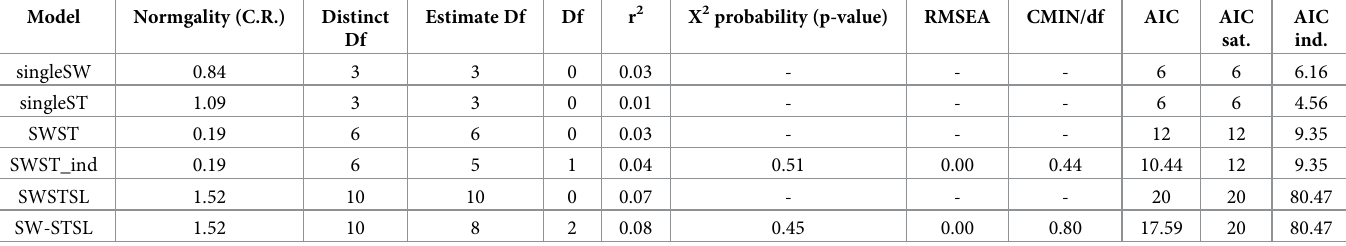
Table 1. Comparison of SEM models, with tests for multivariate normgality, distinct and estimated degrees of freedom, total variance explained, Chi-square statis- tic, Root-mean square error, Chi-square goodness of fit and Akaike information criterion. Model Normgality